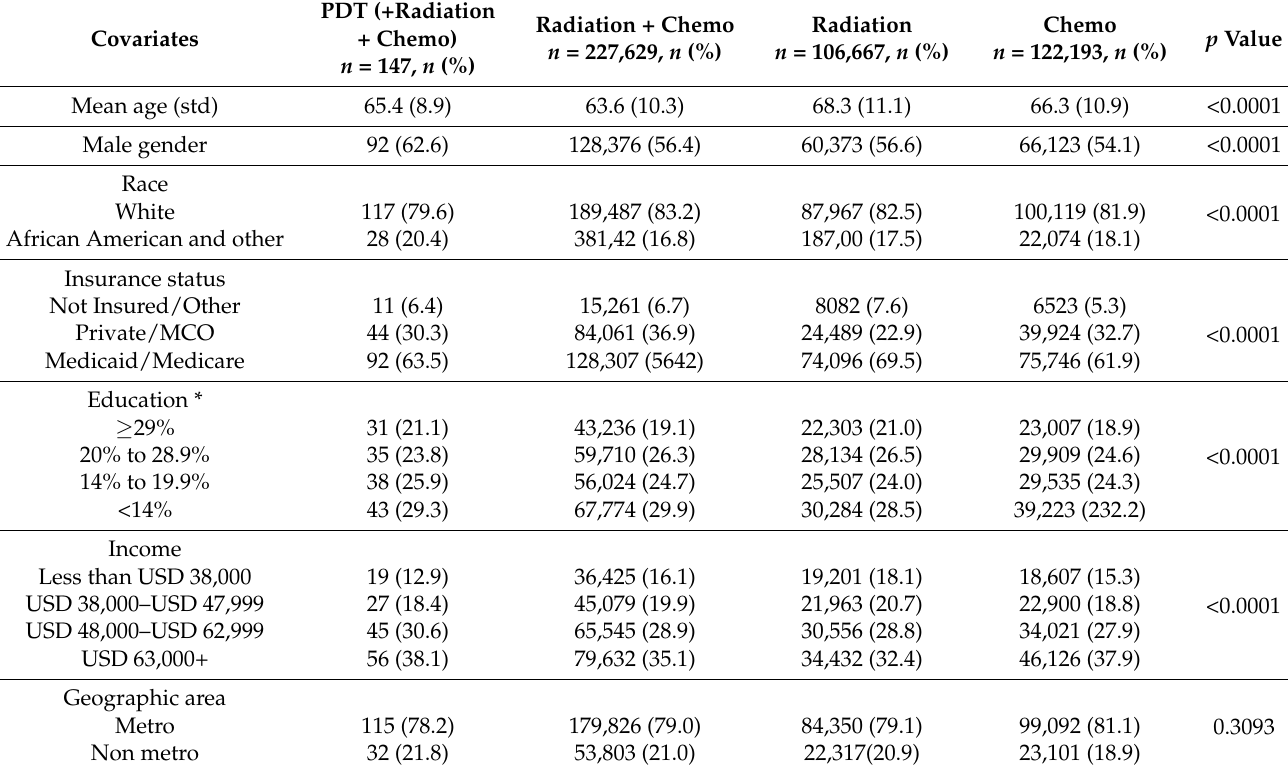
Table 1. Socio-demographic and clinical characteristics comparison (stage